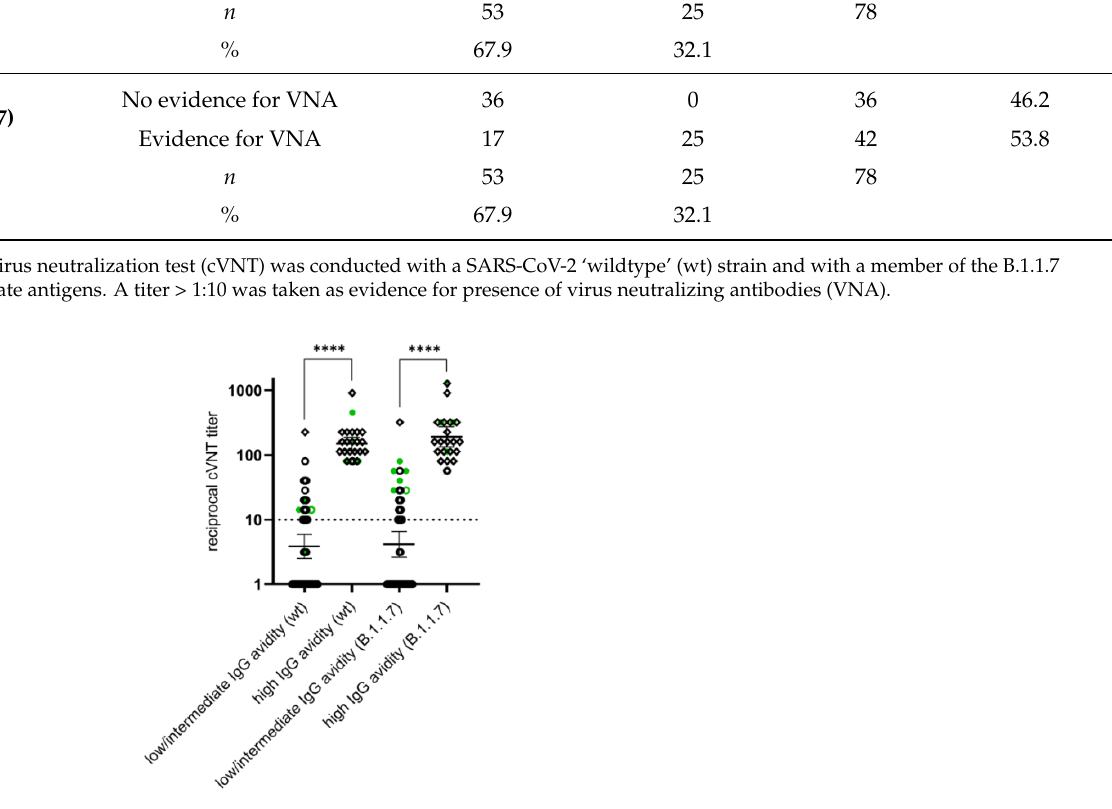
Figure 7. Comparison of immunoglobulin G (IgG) avidity to virus-neutralizing titers obtained with the cell-based neutralization test (cVNT) using a ‘wildtype’ SARS-CoV-2 strain (wt) and a B.1.1.7 virus as antigens. The reciprocal geometric mean titer and the 95% confidence intervals are given. The stars indicate statistical significance (****: p < 0.0001) in an unpaired, non-parametric test (Mann-Whitney test). The sera were collected after infection with SARS-CoV-2 variants of concern (VOCs: B.1.1.7, filled green dots; B.1.351, empty green dots) or after first (black empty dots) and second vaccination (black empty diamonds). A dilution of >1:10 is considered as